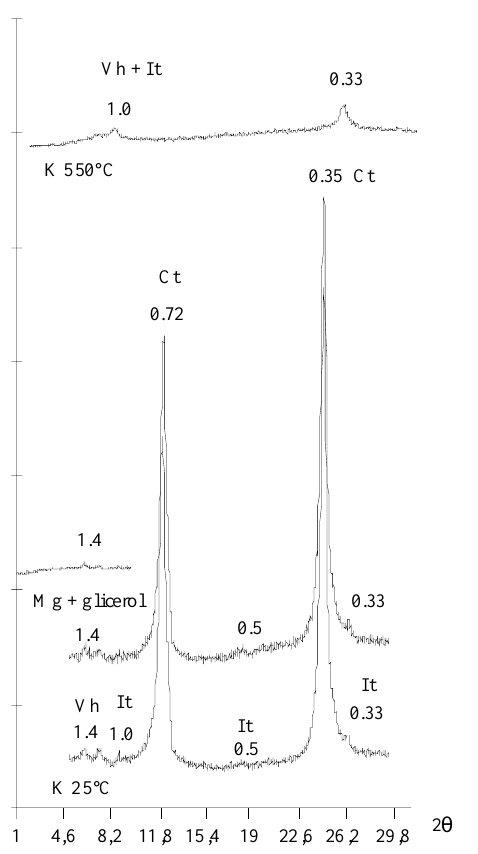
Figura 8. Difratogramas de raios-X da amostra 3B 2 (Perfil 3 – MTf) com os diversos tratamentos. Espaçamento d em nm (Ct = caulinita, Tc = talco, Et = esmectita).